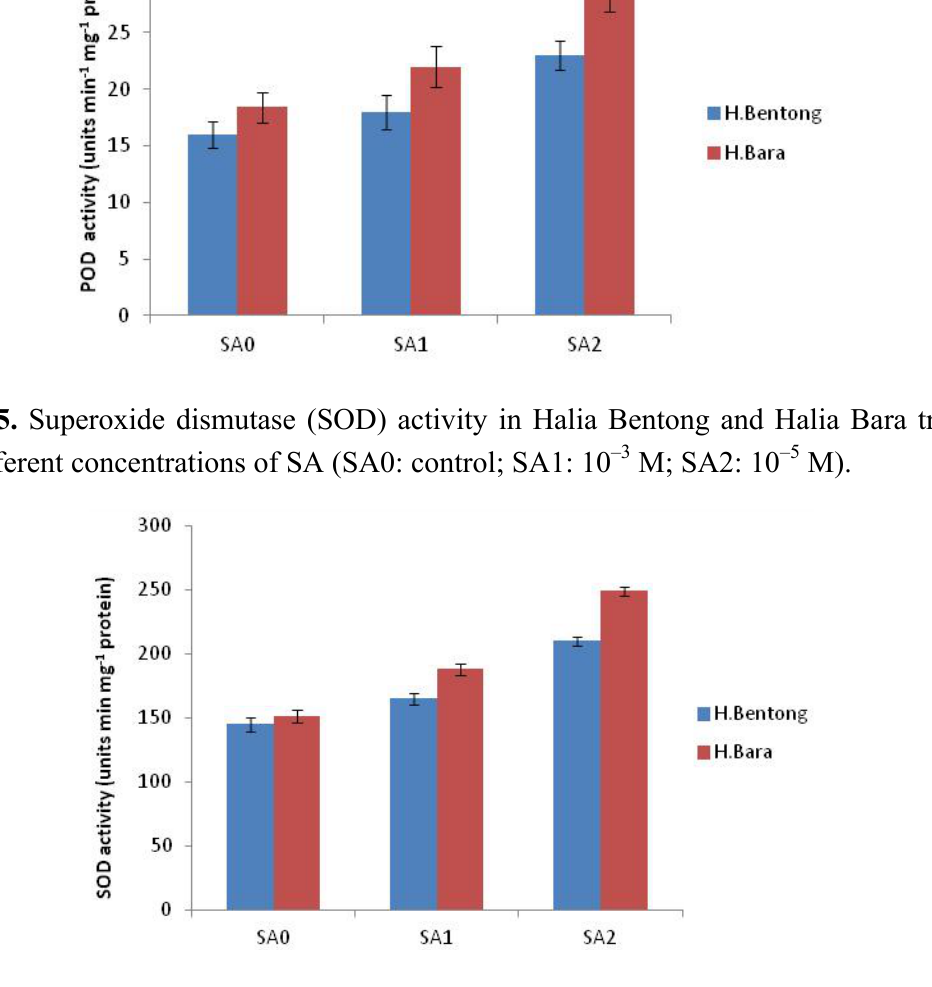
Figure 6. Catalase enzyme activity in Halia Bentong and Halia Bara treated with different concentrations of SA (SA0: control; SA1: 10 –3 M; SA2: 10 –5